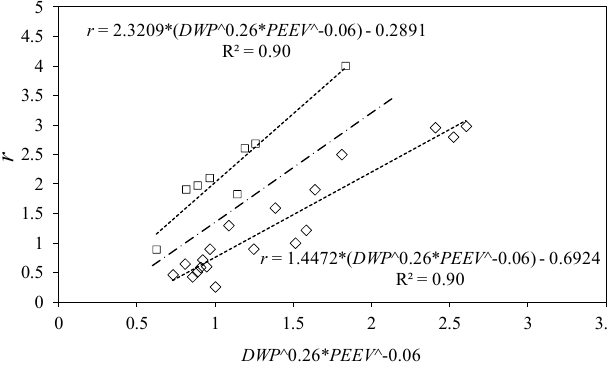
Figure 5. Adjustment of the r parameter in the Vansickle and Beschta [2] modified model. The other parameters included in the model are presented in Table 1. Table 1. Constants of the Vansickle and Beschta [2] modified model.